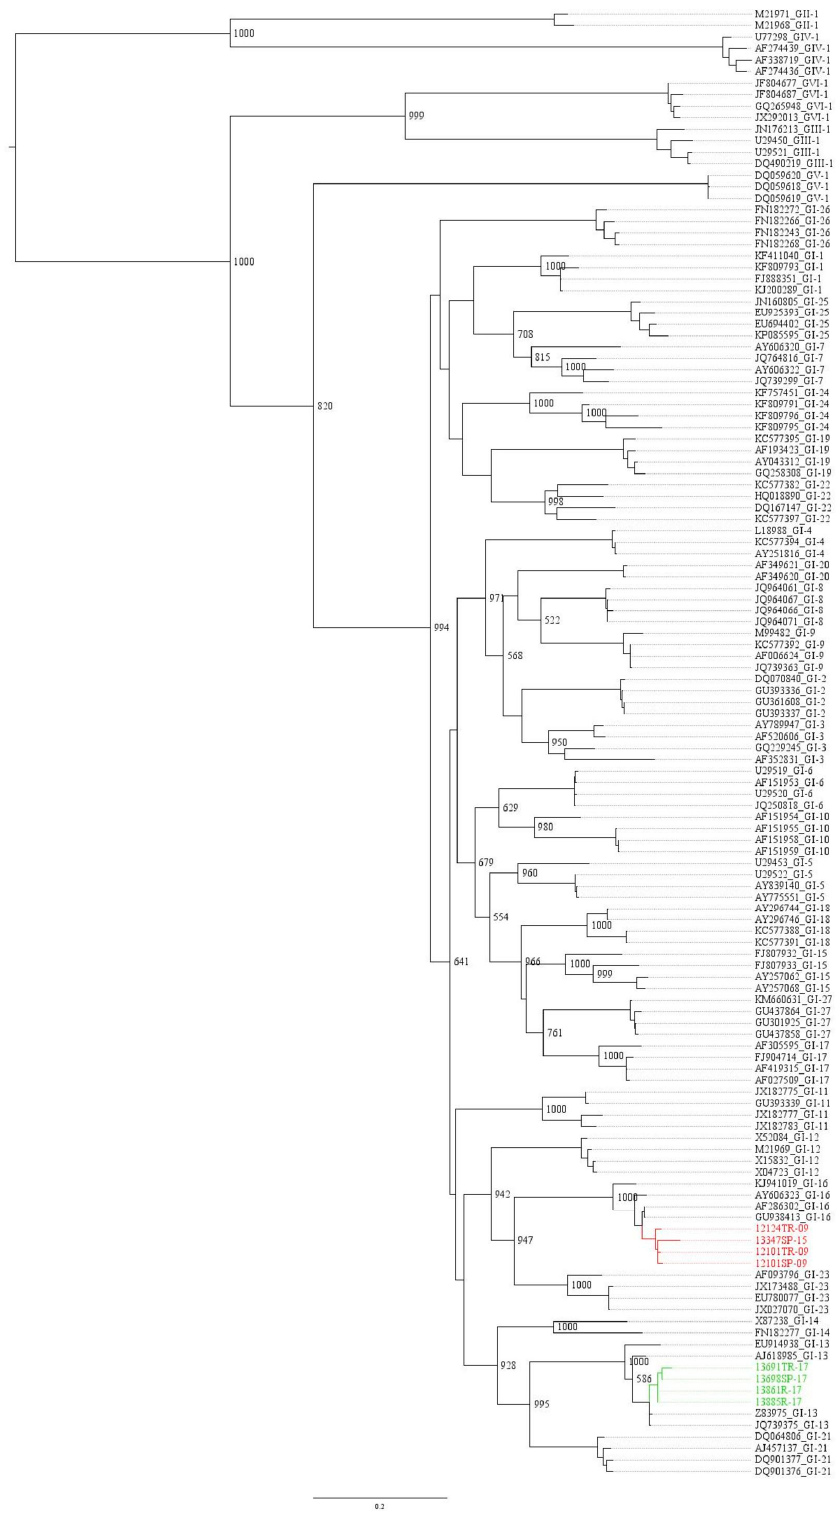
Figure 1. Phylogenetic tree performed by a maximum likelihood method with the PhyML platform v3.0 [26] based on complete S1 region of infectious bronchitis virus (IBV). Red lines indicate Chilean sequences. The tree is rooted in GII and GIV because they showed higher amino-acid distance from other genotypes. The numbers indicate the bootstrap supports of 1000 replicates; only internal nodes over 500 are shown.